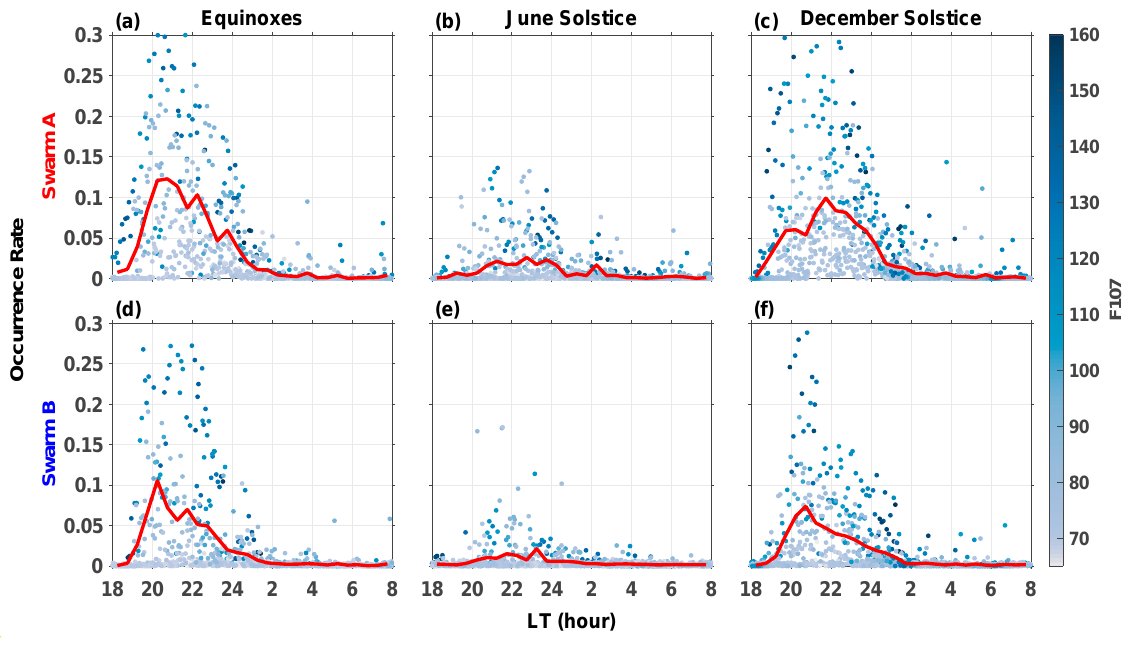
Figure 8. Same as Figure 7 but for ROTI. The panels from left to right show results during the equinoxes ( a , d ), June solstice ( b , e ), and December solstice ( c , f ), from top to bottom show results for Swarm A and Swarm B.